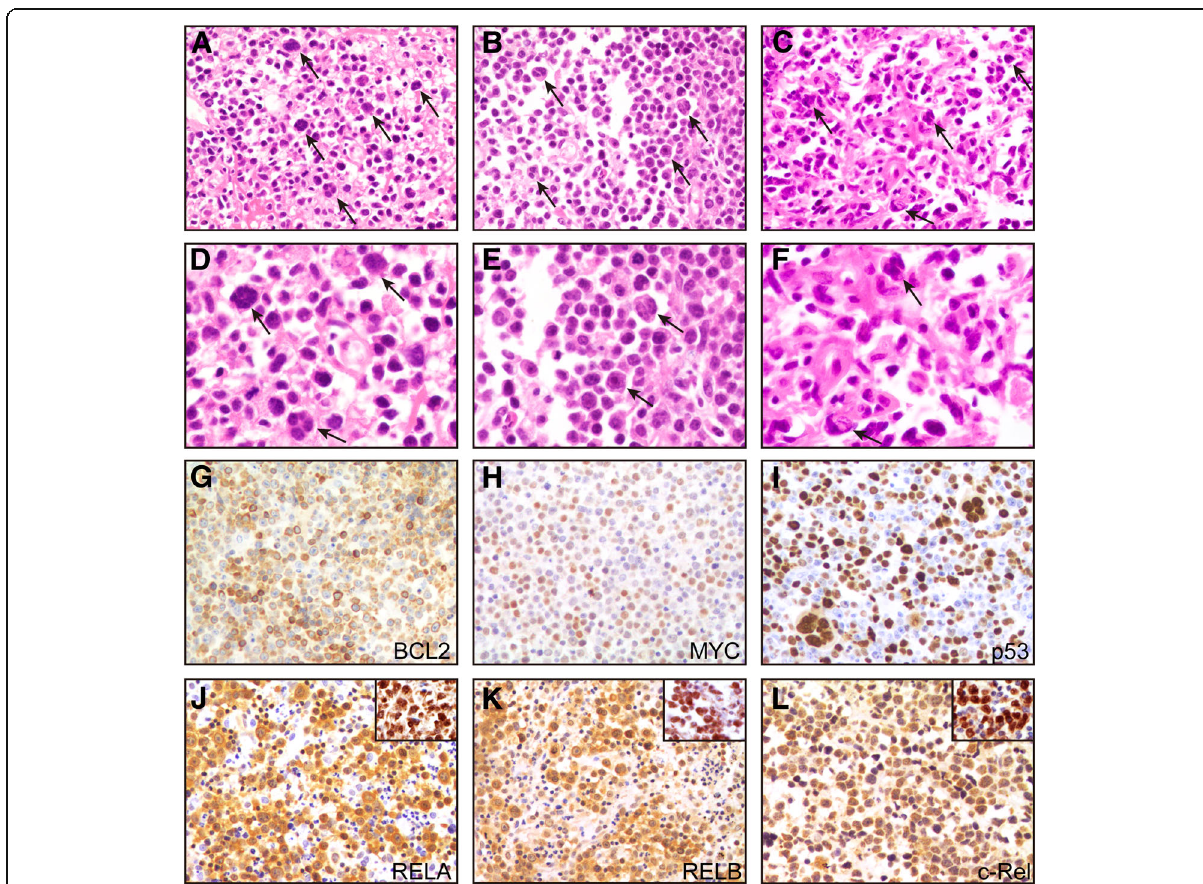
Fig. 1 Representative hematoxylin and eosin (H&E) and immunostaining analysis of primary CNS A-DLBCL. ( a - c ) All three cases showed scattered binucleated and multinucleated, bizarre Reed – Sternberg-like tumor cells (black arrow) in the background of ordinary DLBCL ( a : patient 1, b : patient 2, c : patient 3). ( d - f ) A high power view of the anaplastic tumor cells of each case ( d : patient 1, e : patient 2, f : patient 3). Tumor cells of patient 3 showed a diffuse strong positivity for BCL2 ( g ), MYC ( h ) and p53 ( i ). Patient 2 showed positive staining for the NF- κ B subunits RELA ( j ), RELB ( k ) and c-Rel ( l ) in both cytoplasm and nucleus. A positive control of each immunostaining for anaplastic DLBCL tissues inset at the upper right